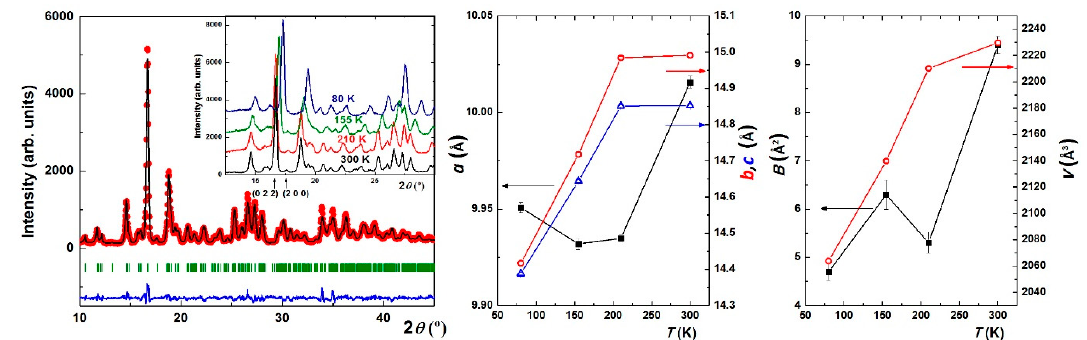
Figure 3. Left : Powder X-ray di ff raction pattern of Fe(3,4-dimethyl-pyridine) 2 [Ag(CN) 2 ] 2 at room temperature. Experimental (red symbols) and calculated patterns (black line), and Bragg peak positions (vertical green marks). Inset: detail of the experimental patterns at room temperature, 210 K, 155 K and 80 K; the arrows indicate the positions of the (0 2 2) and (2 0 0) reflections. Middle : lattice parameters obtained by powder X-ray di ff raction vs. temperature. Right : thermal displacement parameter and cell volume vs.